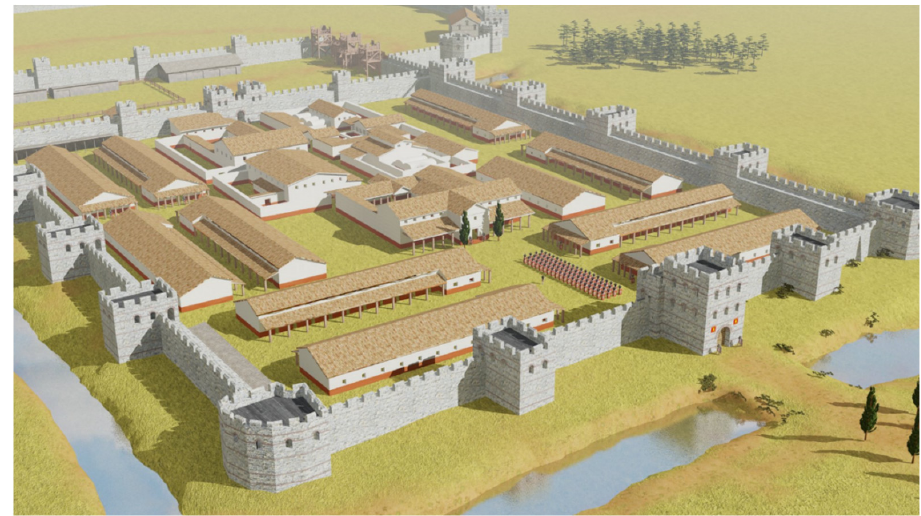
Figure 11. General view of castellum from the northwest.